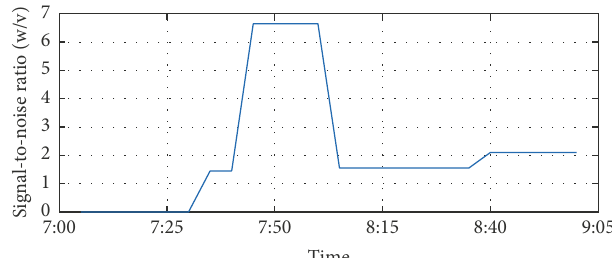
Figure 8: Adaptive parameter updating of DLM model in unforeseen accident situation (road section